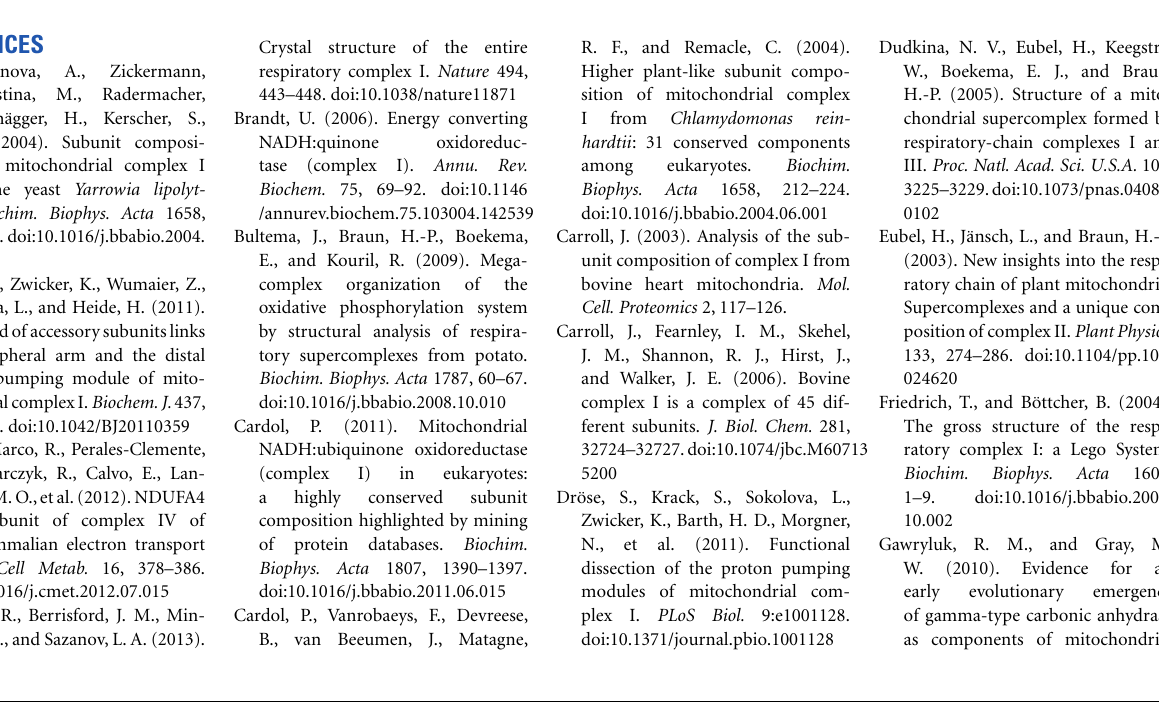
Table S1 | Protein table of the GelMap (http://www.gelmap.de/arabidopsis-3d-complex-i/).